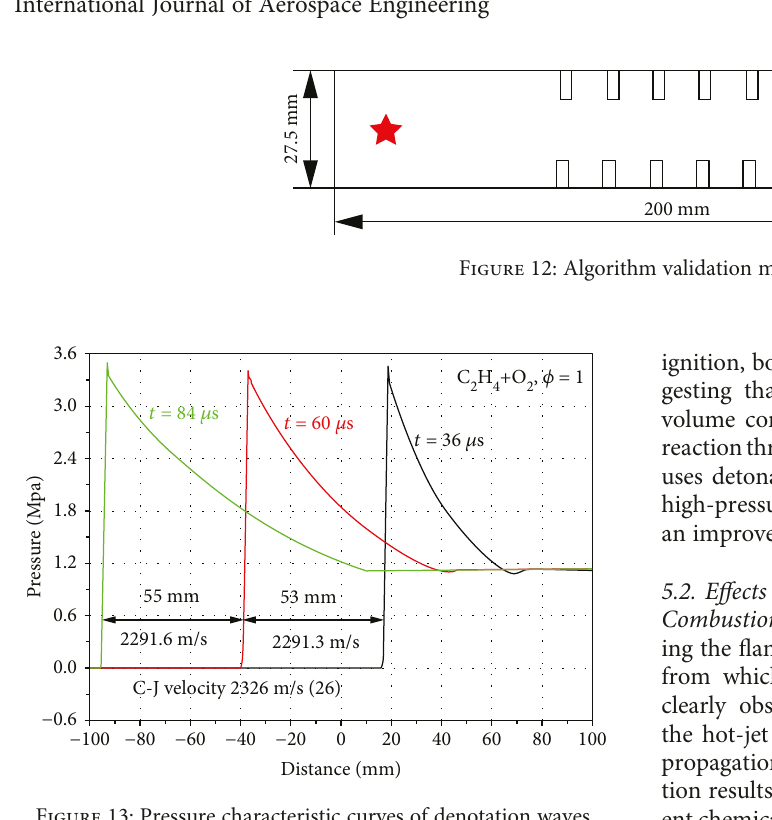
Figure 13: Pressure characteristic curves of denotation